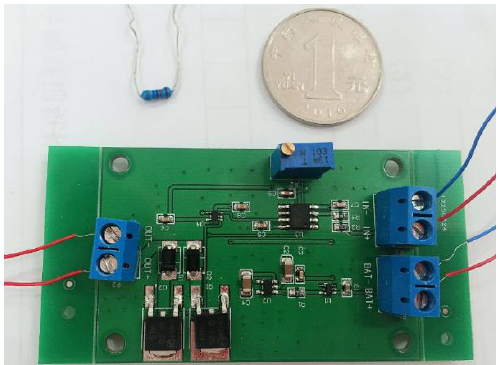
Figure 15. Circuit board of the switching control.